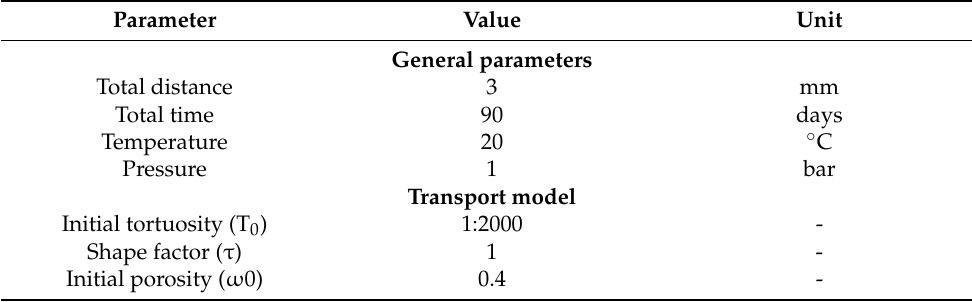
Table A1. Reactive Mass Transport (RMT) model input